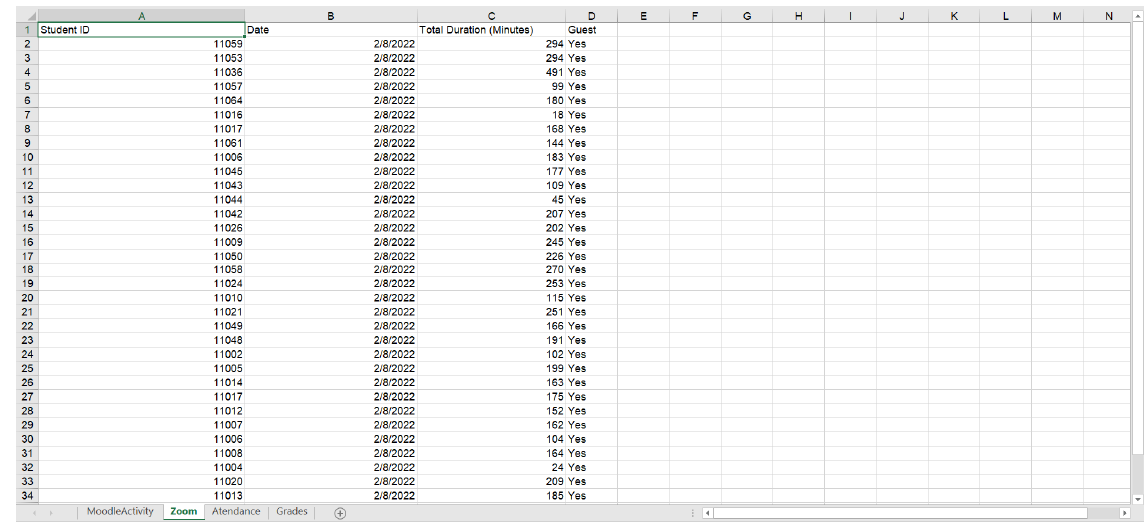
Figure 2. Data from Zoom.